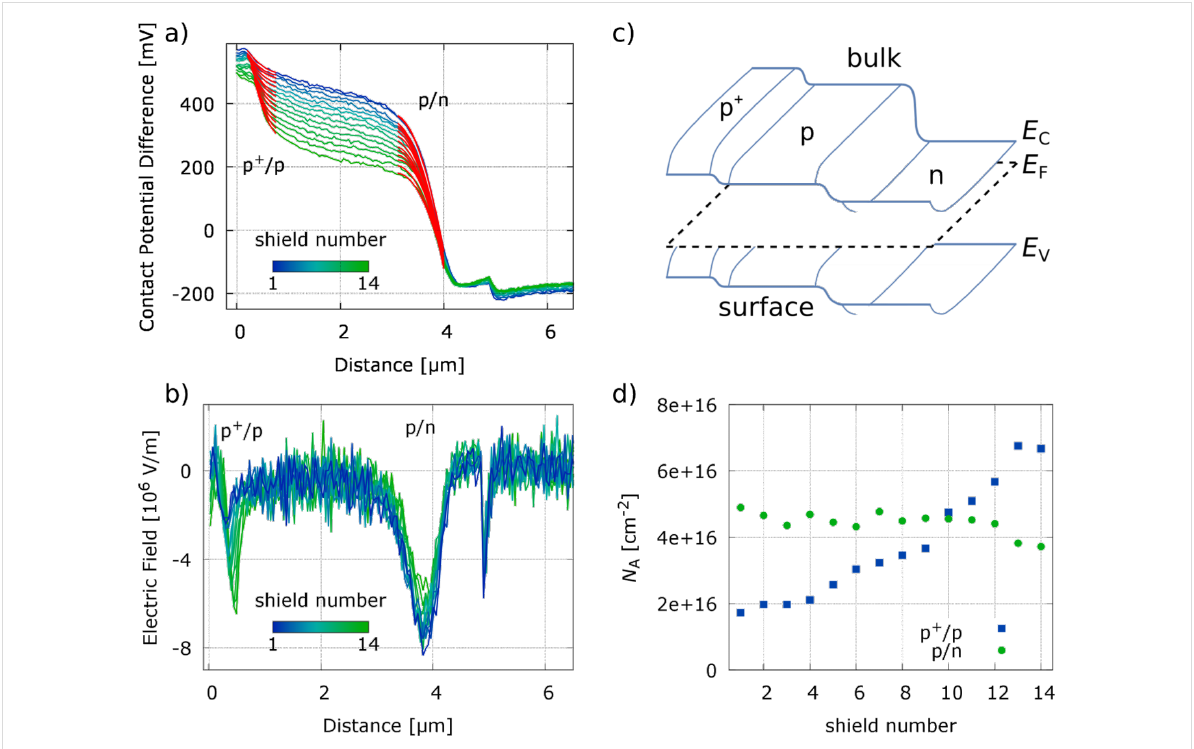
Figure 9: a) Close view of the line sections from Figure 8e at the top layer of the structure, together with least-square fits through Equation 2 of the p + /p- and p/n-interface in red. b) Calculated electric field from panel a again from shield 1 to 14. The determined built-in voltage V b and SCR width W from the fits were used to calculate the acceptor concentration N A , as presented in panel d, of the p-type layer at the 14 different positions for both the p + /p- and the p/n-interface. c) shows a schematic view of the complex band bending features expected at the surface of the SiC cross